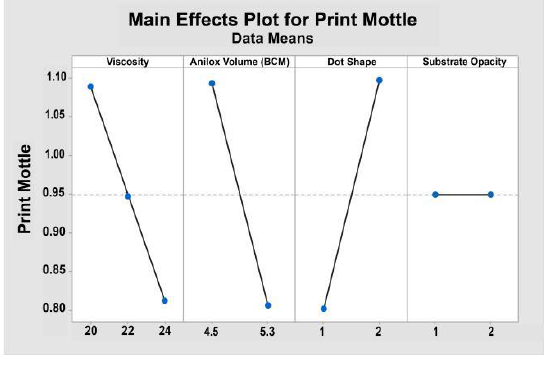
Figure 12. Main effect plot for print